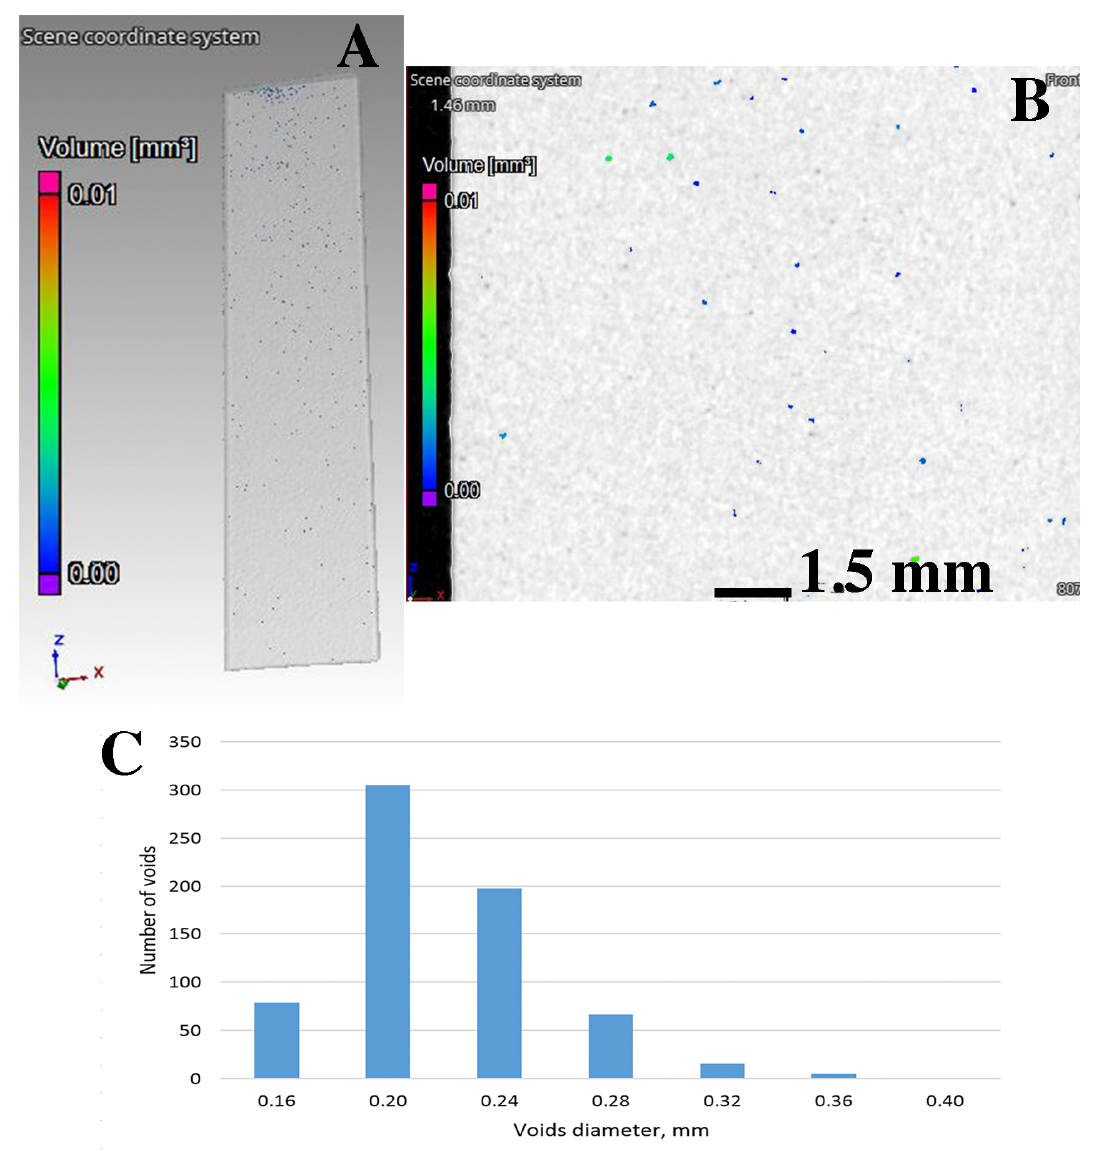
Figure 8. The results of CT tests of samples made of AlSi10Mg–AM: ( A ) sample 3D model, ( B ) porosity in cross-section and ( C ) diameter and volume distribution of separate pores.